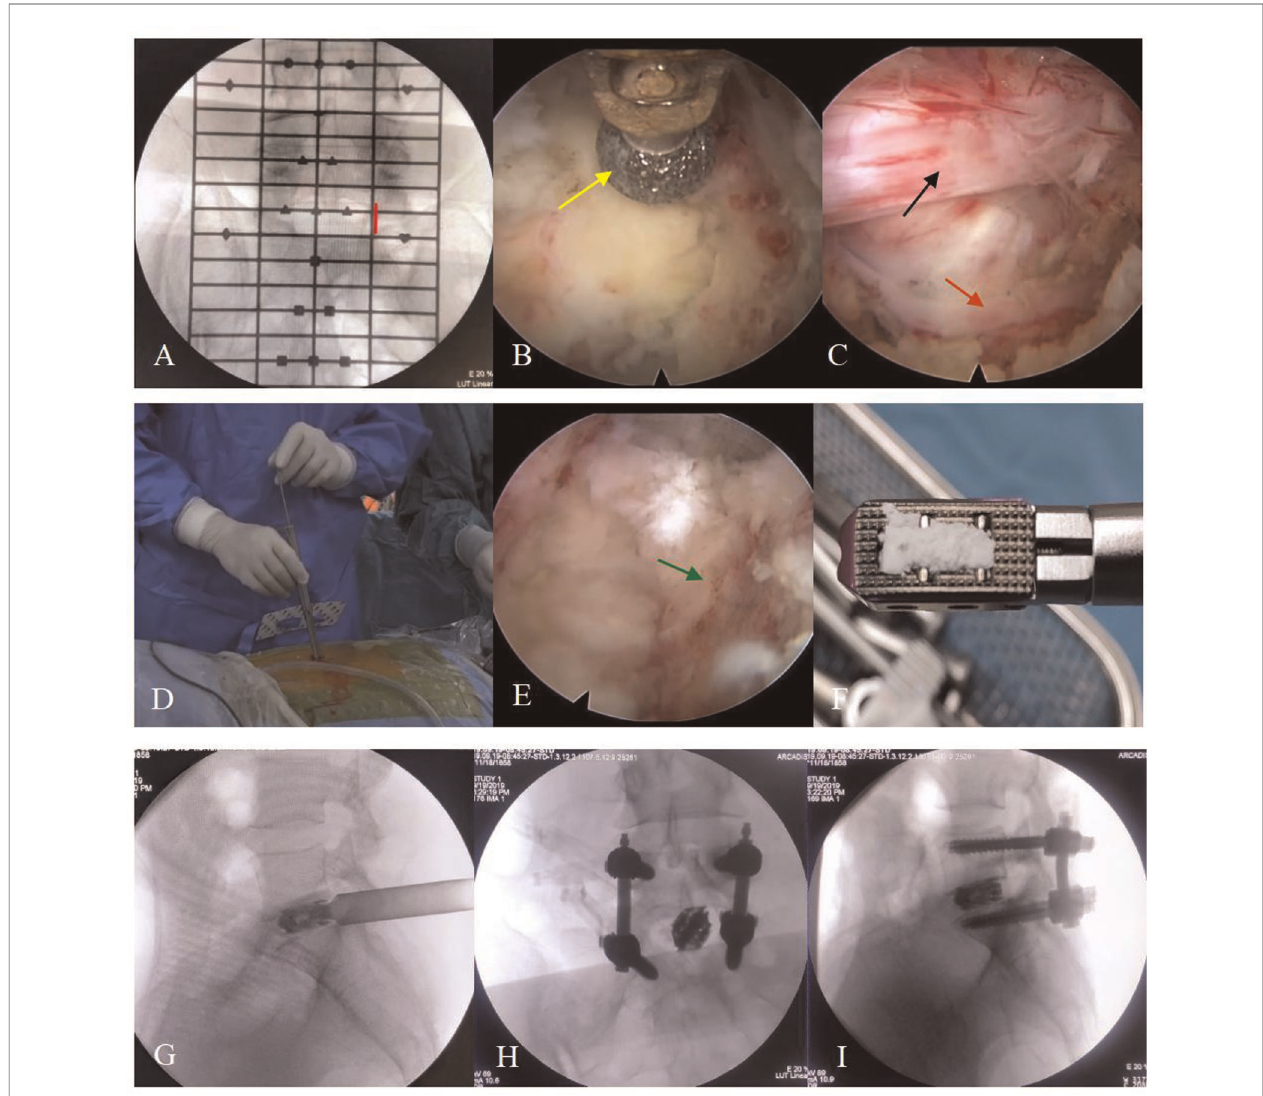
FIGURE 1 | The surgical steps. ( A ) The positioning device is used to identify the responsible segment and decide the location of the incision (red line). ( B ) The articular process (yellow arrow) is polished by endoscopic burrs. ( C ) The vessel (red arrow) and nerve root (black arrow) are exposed before entering into the spinal canal. ( D ) The working channel is replaced before placing the expandable cage. ( E ) The cartilaginous endplate is removed and the bony endplate (green arrow) is exposed. ( F ) The cage is grafted with the bone before implantation. ( G – I ) The position of the cage and percutaneous pedicle screws is con fi rmed by “ C-arm ” fl uoroscopy when